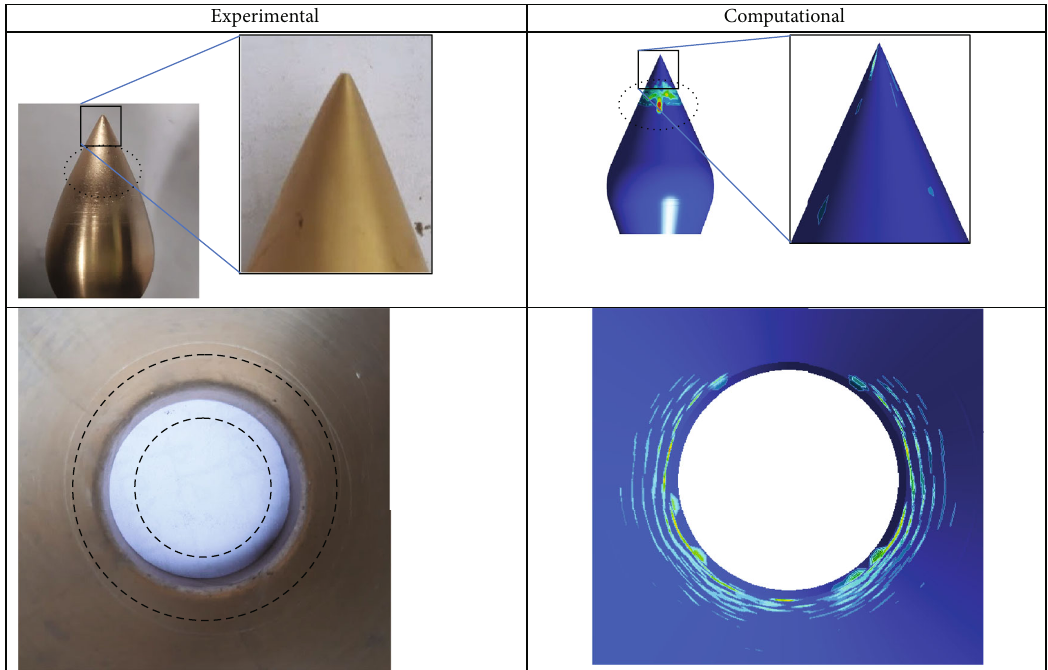
Figure 13: Comparison of needle and nozzle Erosion (after 12hrs of operation).